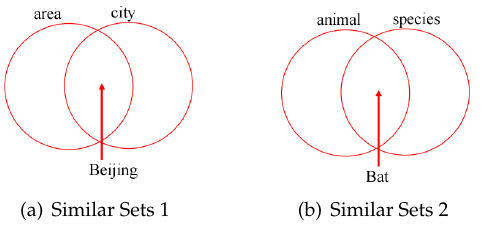
Figure 1. Similar concept sets.